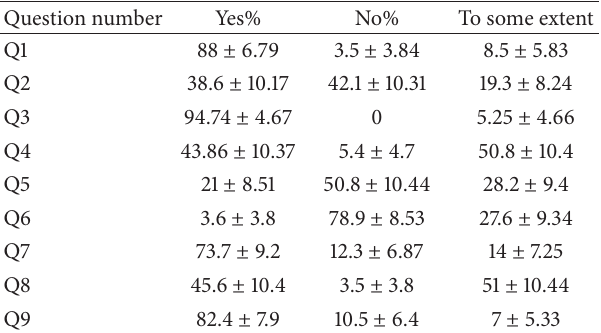
Table 2: Responses of